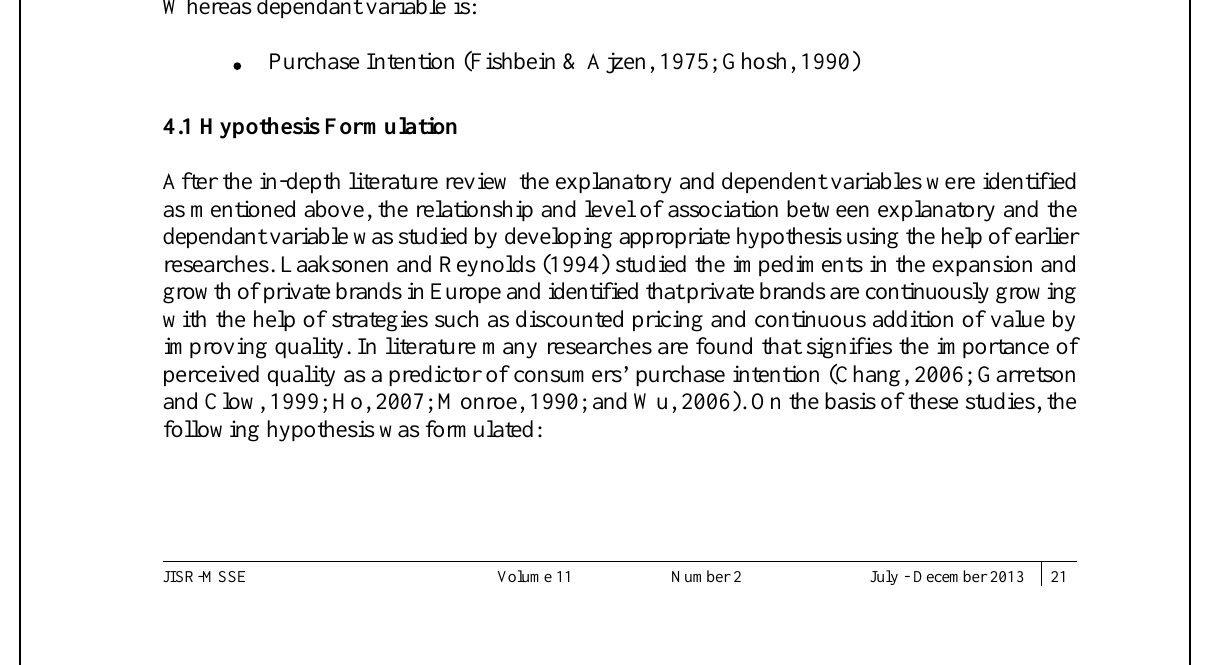
Perceived Price Packaging Perceived Perceived Risk